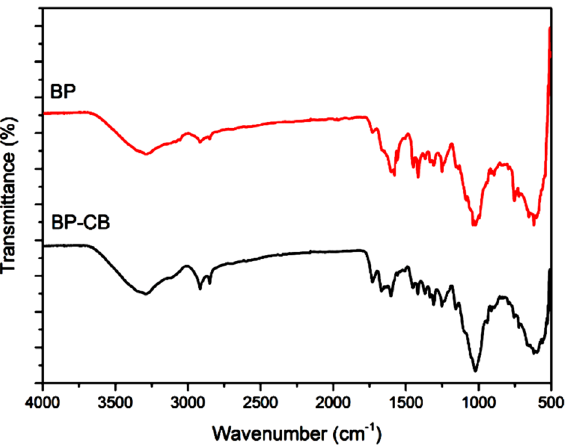
Figure 3. Infrared spectrum of bean bark powder before adsorption (BP) and after adsorption (BP-CB).